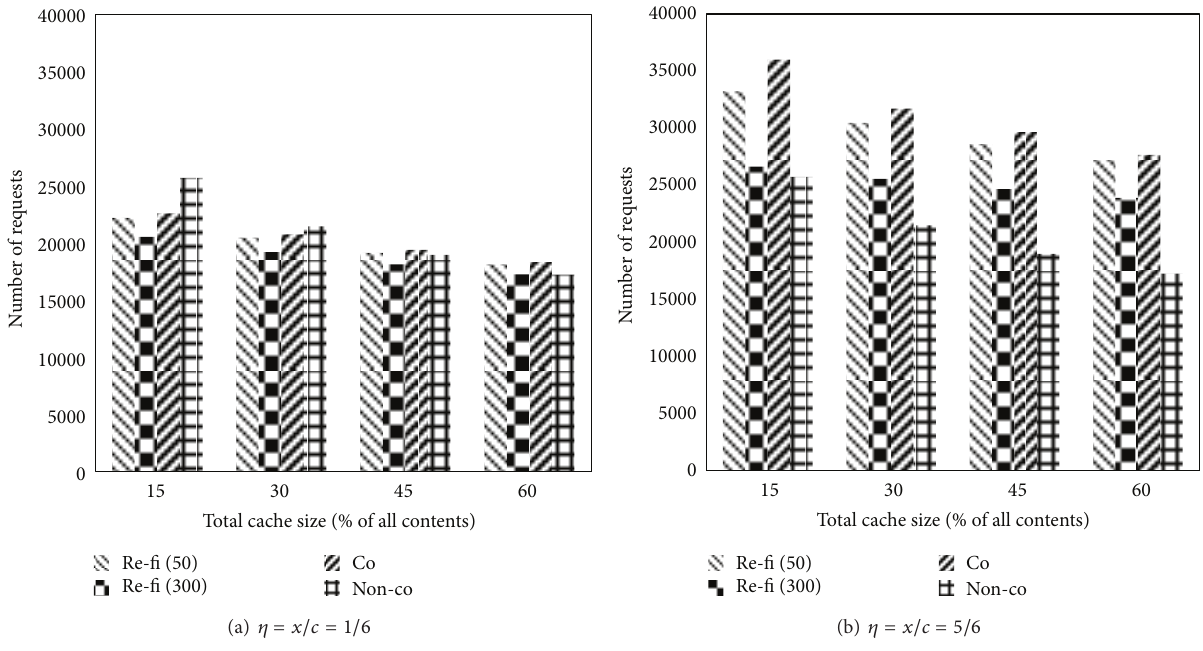
Figure 8: Number of requests versus cache